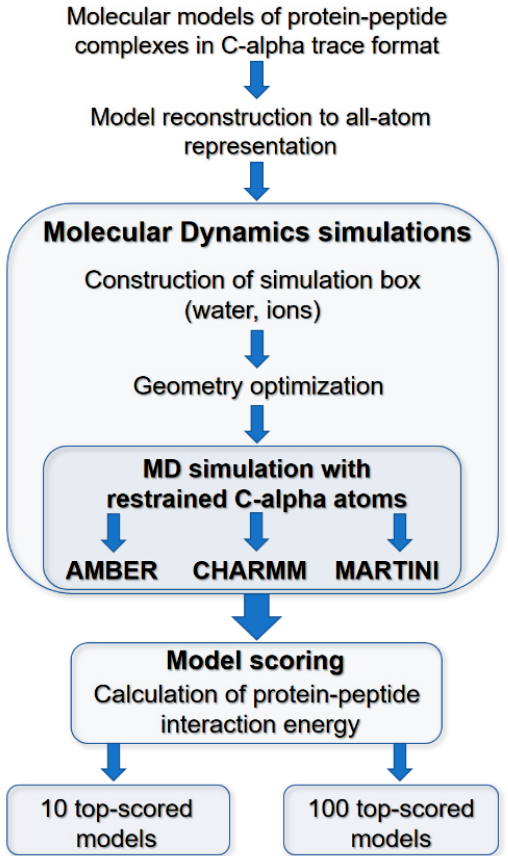
Figure 4. Main stages of the model scoring procedure. Scoring procedure includes: (i) reconstruction of C-trace models to AA representation; (ii) MD simulations of protein–peptide complexes in water environment using CHARMM, AMBER, and MARTINI parametrization; (iii) model scoring: calculation of protein–peptide interaction energy and RMSD values for bound peptide ligands.